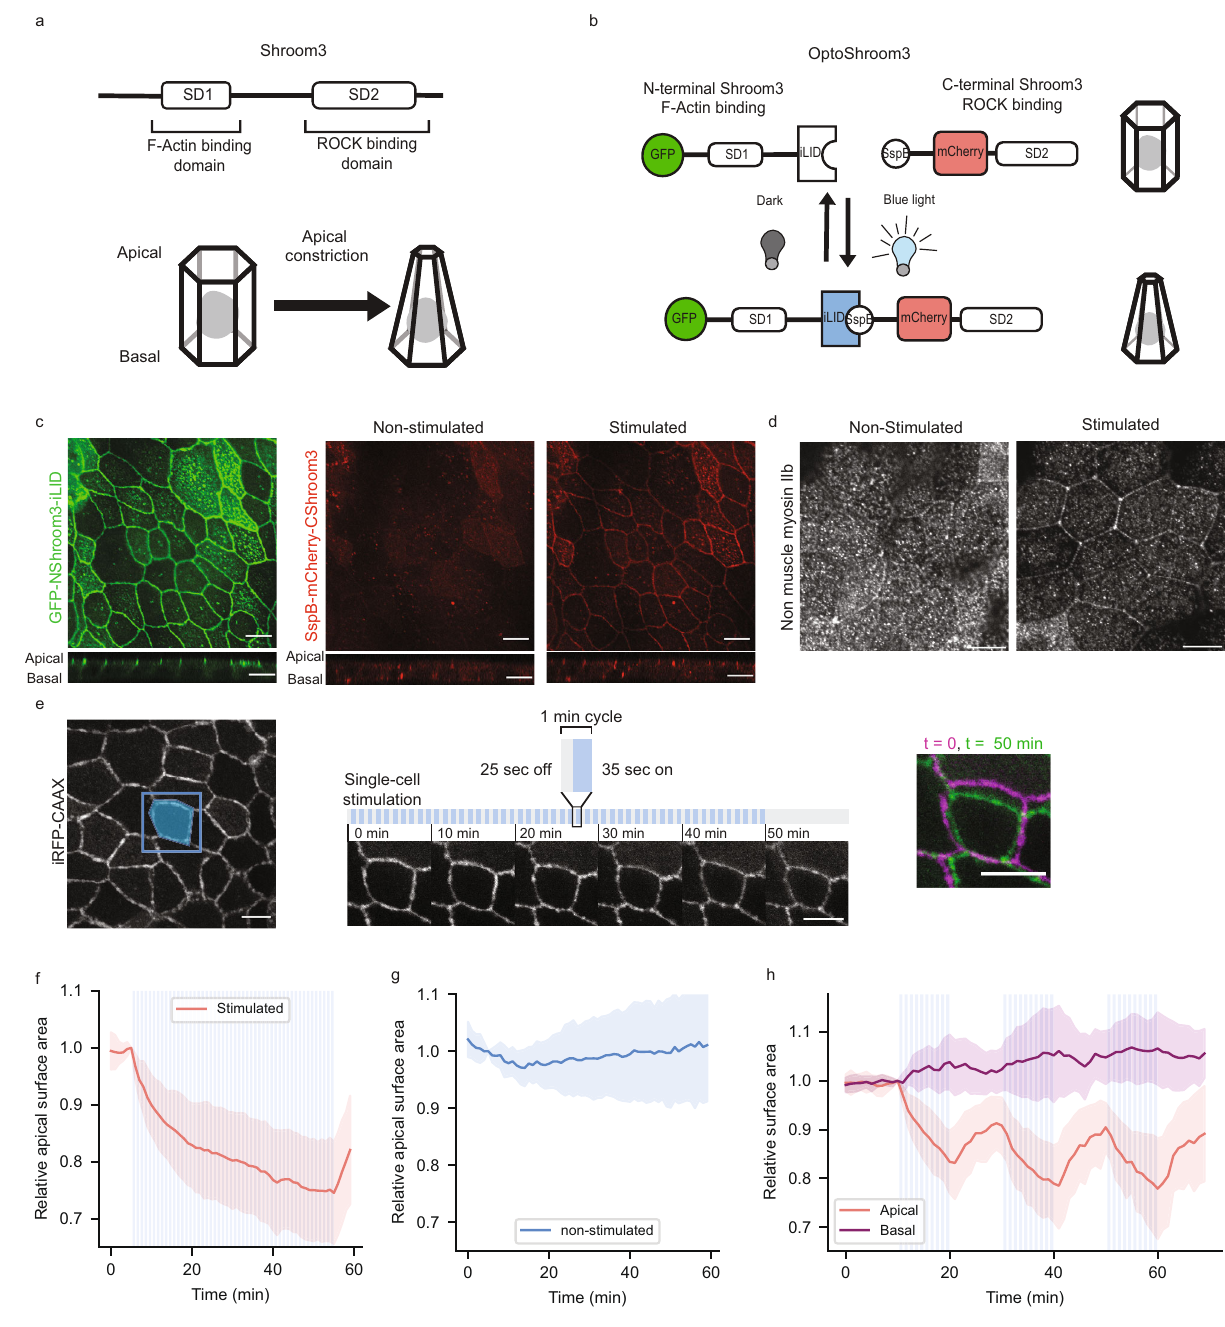
Fig.1|CharacterizationofOptoShroom3-inducedapicalconstriction.a Protein structure of wild-type Shroom3 and scheme of apical constriction. b Design of OptoShroom3 constructs that dimerize upon blue light stimulation. c MDCK cells expressing GFP-NShroom3-iLID and SspB-mCherry-CShroom3 before and after 1-min stimulation. Top: x-y apical slice, bottom: x-z lateral slice. Scale bar=10 μ m. d Non-muscle myosin IIb stainings of OptoShroom3 MDCK cells under no stimu- lation (left) and 2-h blue light stimulation (right). Apical slices. Scale bar=10 μ m. e Single-cell stimulation cycles and representative images from constriction